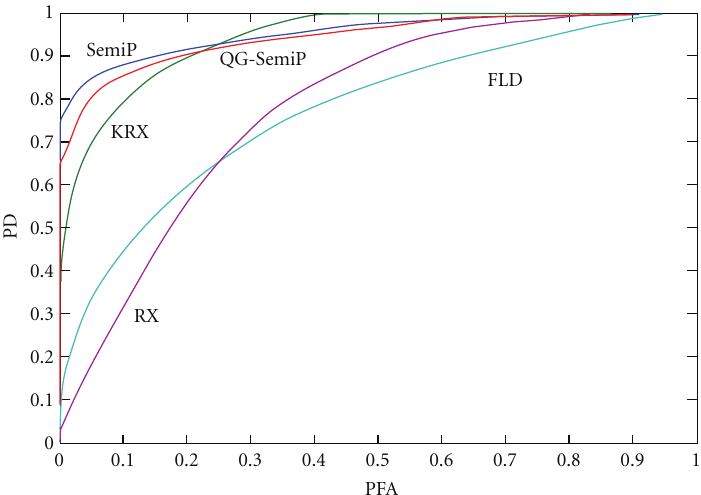
Figure 15: ROC curves for the nadir looking imagery (Cube 1) data scene shown in Figure 1. The semiparametric method, being used in both local and quasiglobal versions, are noticeably less sensitive to di ff erent cuto ff thresholds; their performances almost achieve an ideal ROC curve for that scene, that is, a step function starting at point (PFA = 0,PD =